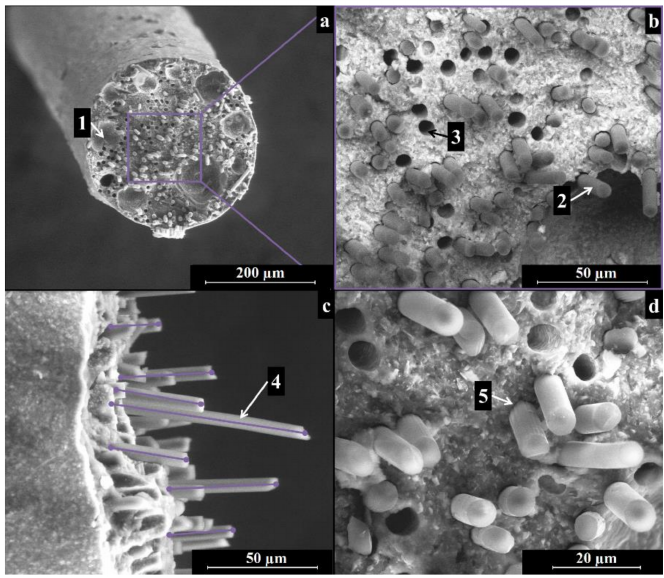
Figure 5. SEM images of a pyrolyzed filament produced with Ink B using a 410- µ m nozzle: ( a ) an overview of the cross-section; ( b ) homogeneous fiber and filler distribution in the filament; ( c ) fiber alignment and pull out; ( d ) close up of the interface between fibers and matrix. Legend: (1) air voids; (2) carbon fibers; (3) voids left by carbon fibers pulled-out during fracture; (4) fiber pull-out; (5) interface between matrix and fibers.